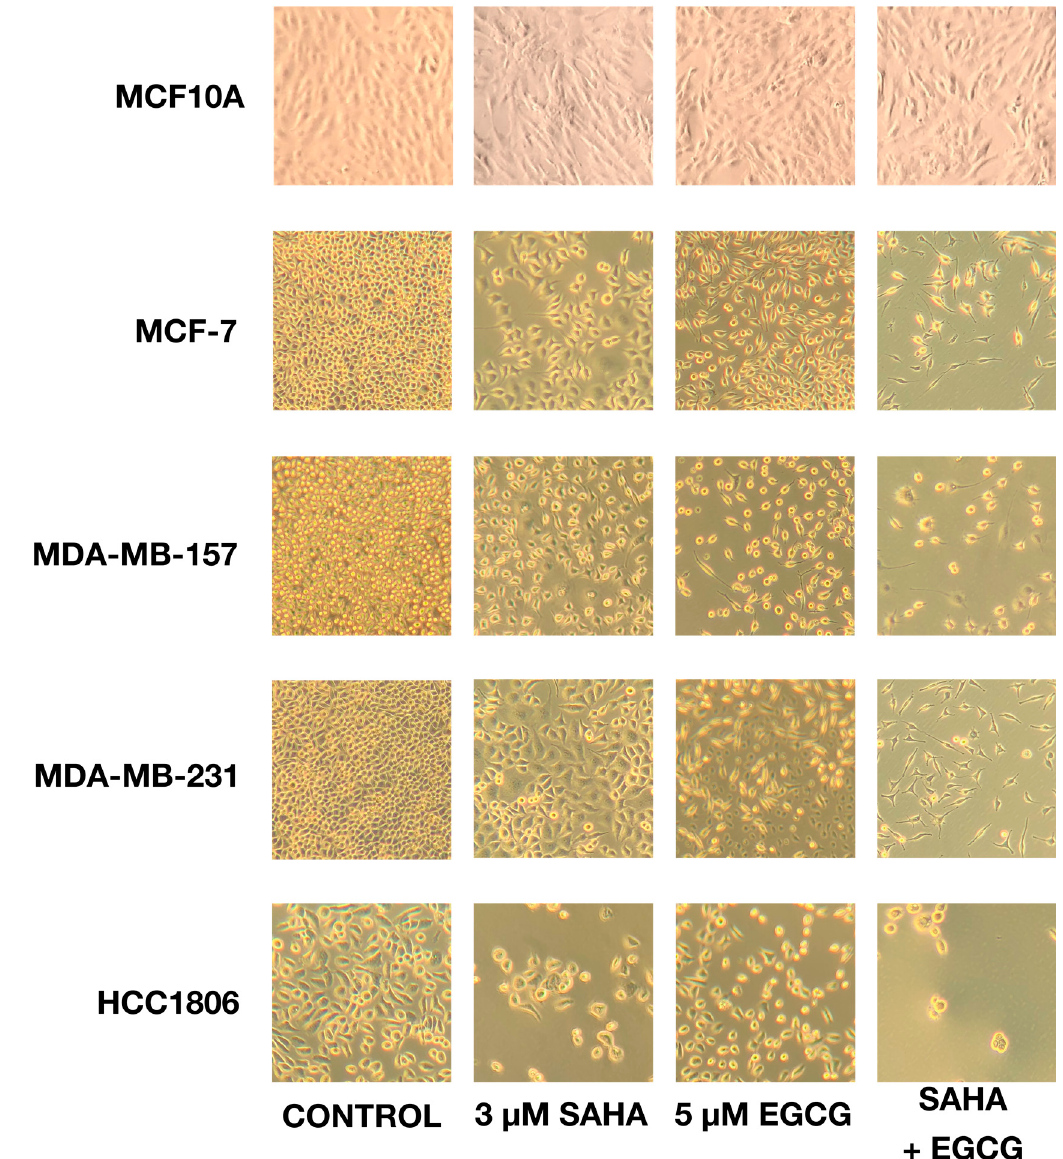
Figure 1. SAHA and EGCG diminish cell density when seeded on a 6-well plate. Cells (2 × 10 5 ) were plated on a 6-well plate and treated with SAHA and EGCG alone or in combination (3 µ M SAHA + 5 µ M EGCG) for 72 h. SAHA and EGCG administered singly were able to reduce the cell density, but not as much as the combination of 3 µ M SAHA and 5 µ M EGCG. With this combination treatment, not only were there fewer cells present on the plate, but the cells that were visible appeared to be more fibroblastic, suggesting a more highly differentiated state. There was no apparent change in cell density with the treatments in the MCF10A cells. All photos were taken at 100 ×